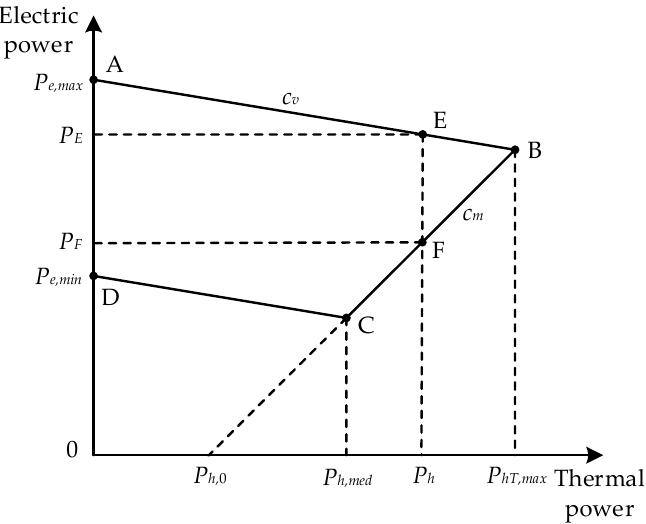
Figure 1. Electric and thermal characteristics of conventional cogeneration unit. 108